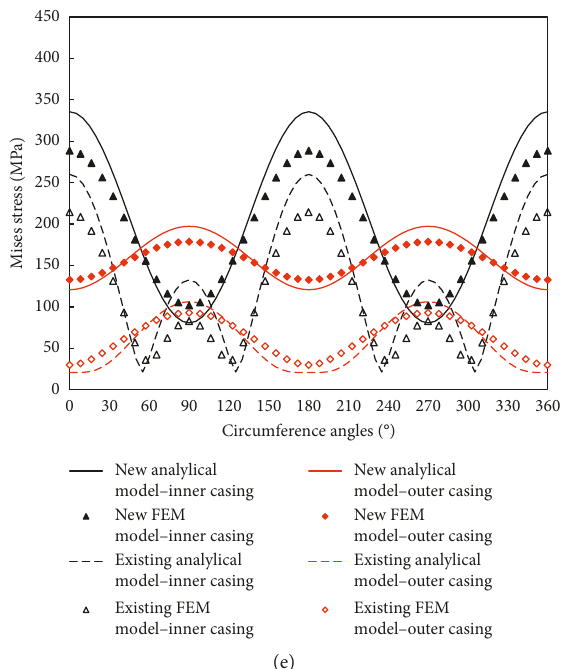
Figure 14: Comparison of numerical and analytical solutions. (a) Radial stress along the radial directions of 0 ° and 90 ° . (b) Radial stress at the internal casing wall. (c) Circumferential stress along the radial directions of 0 ° and 90 ° . (d) Circumferential stress at the internal casing wall. (e) Mises stress at inner and outer casing walls.